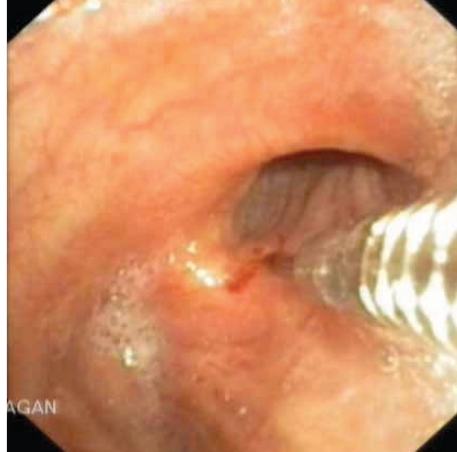
Figure 5. The coagulated lesion is shown in middle of the picture, with the argon plasma probe on the right.